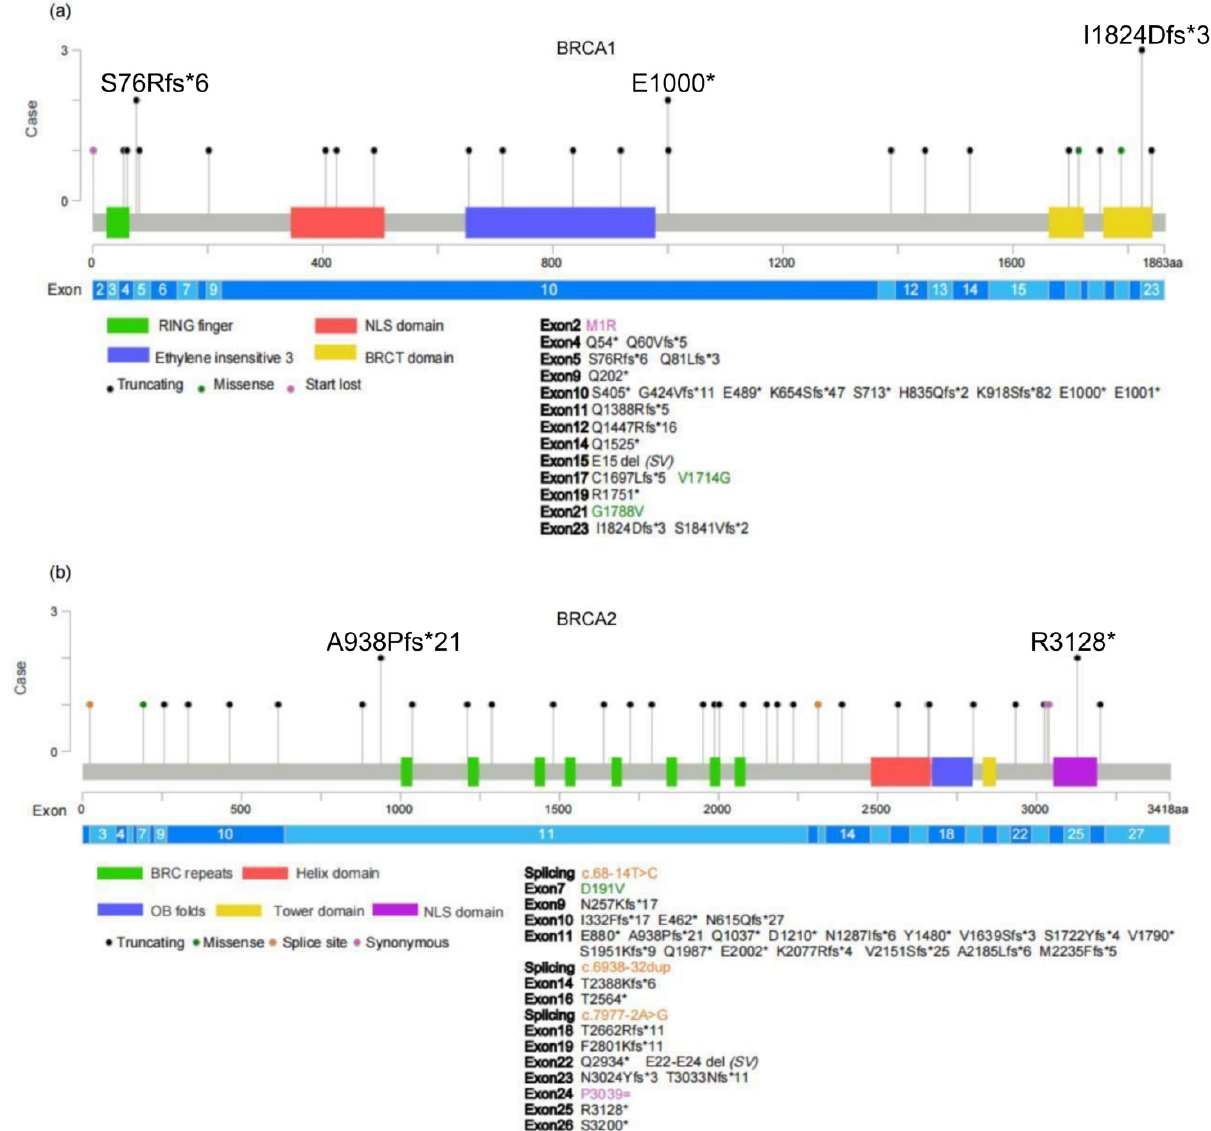
Figure 2. Locations of variants in the BRCA1/2 proteins. ( a ) The variants in BRCA1 protein. E15 deletion ( n = 1) is not presented in the graph. ( b ) The variants in BRCA2 protein. E22-E24 deletion ( n = 1) is not presented in the graph. Abbreviation: BRCT = the BRCA carboxyl terminus domain; NLS = nuclear localization signal; OB folds = oligonucleotide binding-folds; SV = structure variants; * = nonsense variant.